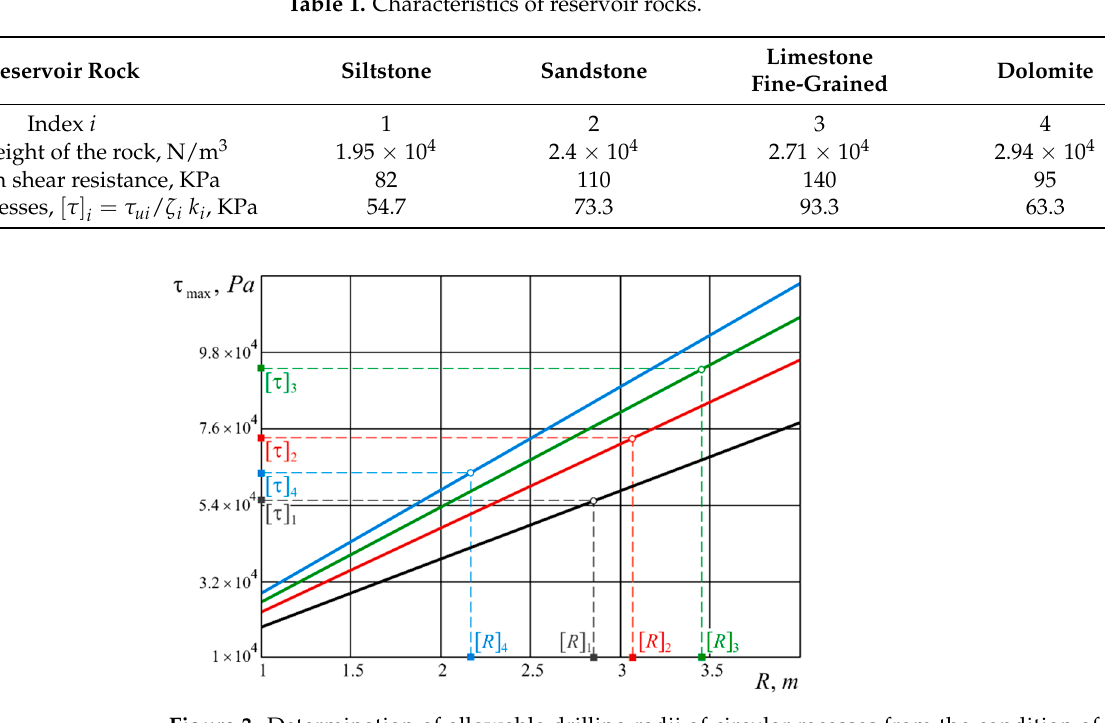
Table 1. Characteristics of reservoir rocks.